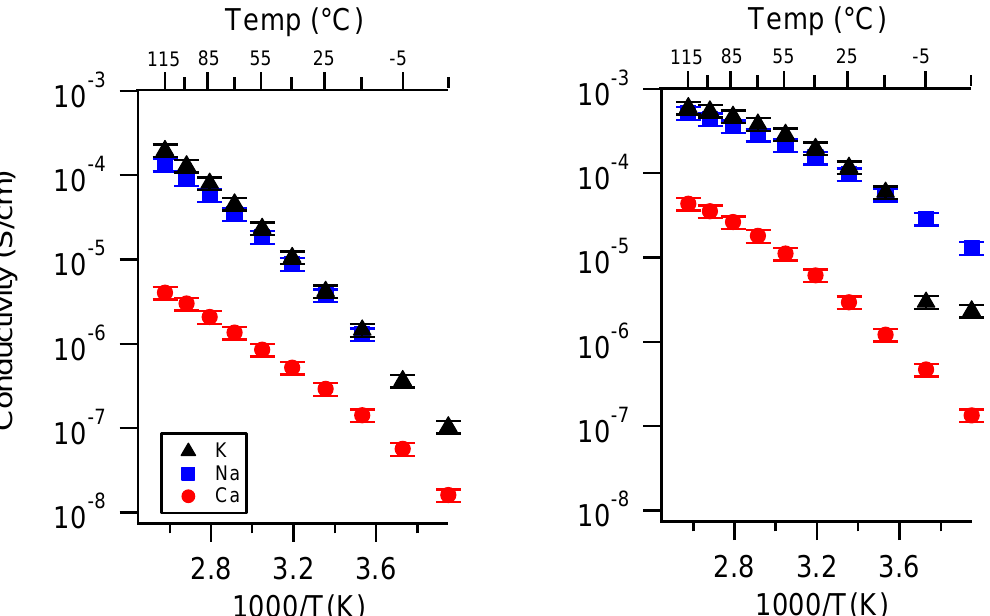
Figure A8. Conductivity as a function of cation for PEGDMA1000_med_SSM (left) and PTHFDA1000_med_STFSI (right) SIPEs swelled with ECPC. Temperatures ranged from − 20 °C to 115 °C.